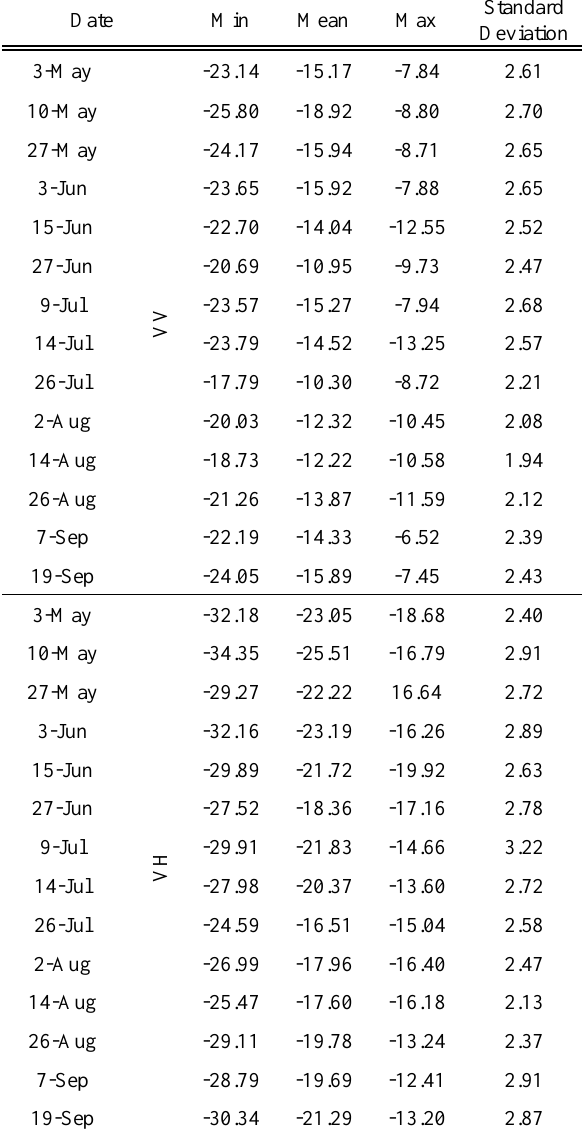
Table 3 Descriptive statistics (minimum, mean, maximum and standard deviation) of VH and VV captured at the 133 polygons of current wheat cropping area from cadastre data in the studied field, for each date, between May and September 2019. Despite inter-month differences, the general trend consists of wheat in VH and VV backscatter values at the beginning of spring, reaching a maximum value during 10 May, followed by a clear decrease, which is mainly related to the beginning of cultivation as a start from 10 May with ploughing soil. Fig. 6 obtained strong and significant incenses on values of VH and VV between June and August. Backscatter values of VH and VV are responsive to changes in both the water content and the biomass of crops. The values as VH/VV are decreased in Mid- July, this pattern, typical of dryland ecosystems, reflects the conjugation of the effects of air temperature and precipitation and their influence on SMC, PMC and vegetative